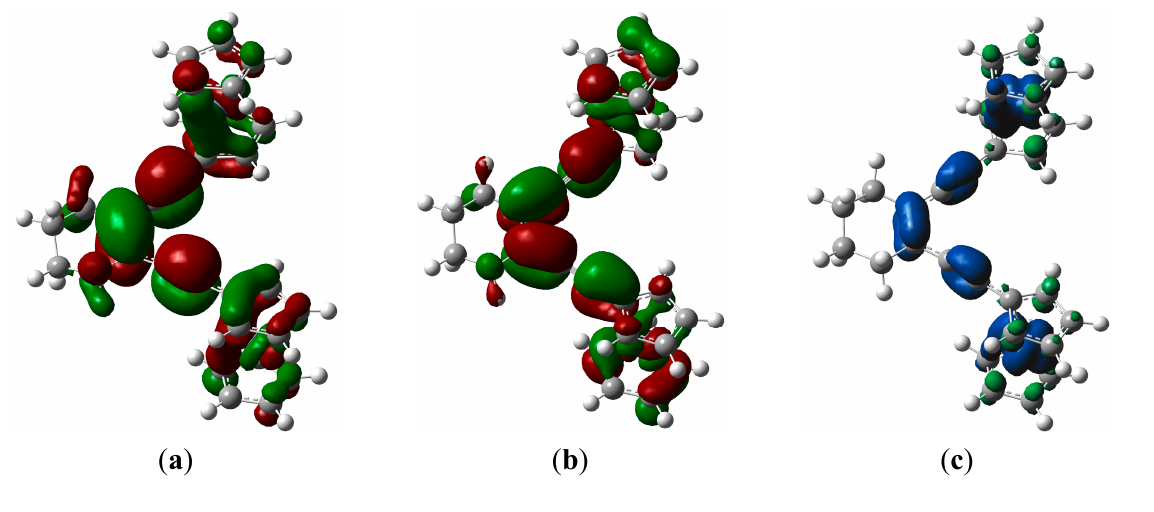
Figure 5. SOMO ( a ); LUMO ( b ) and spin density ( c ) of 3 +